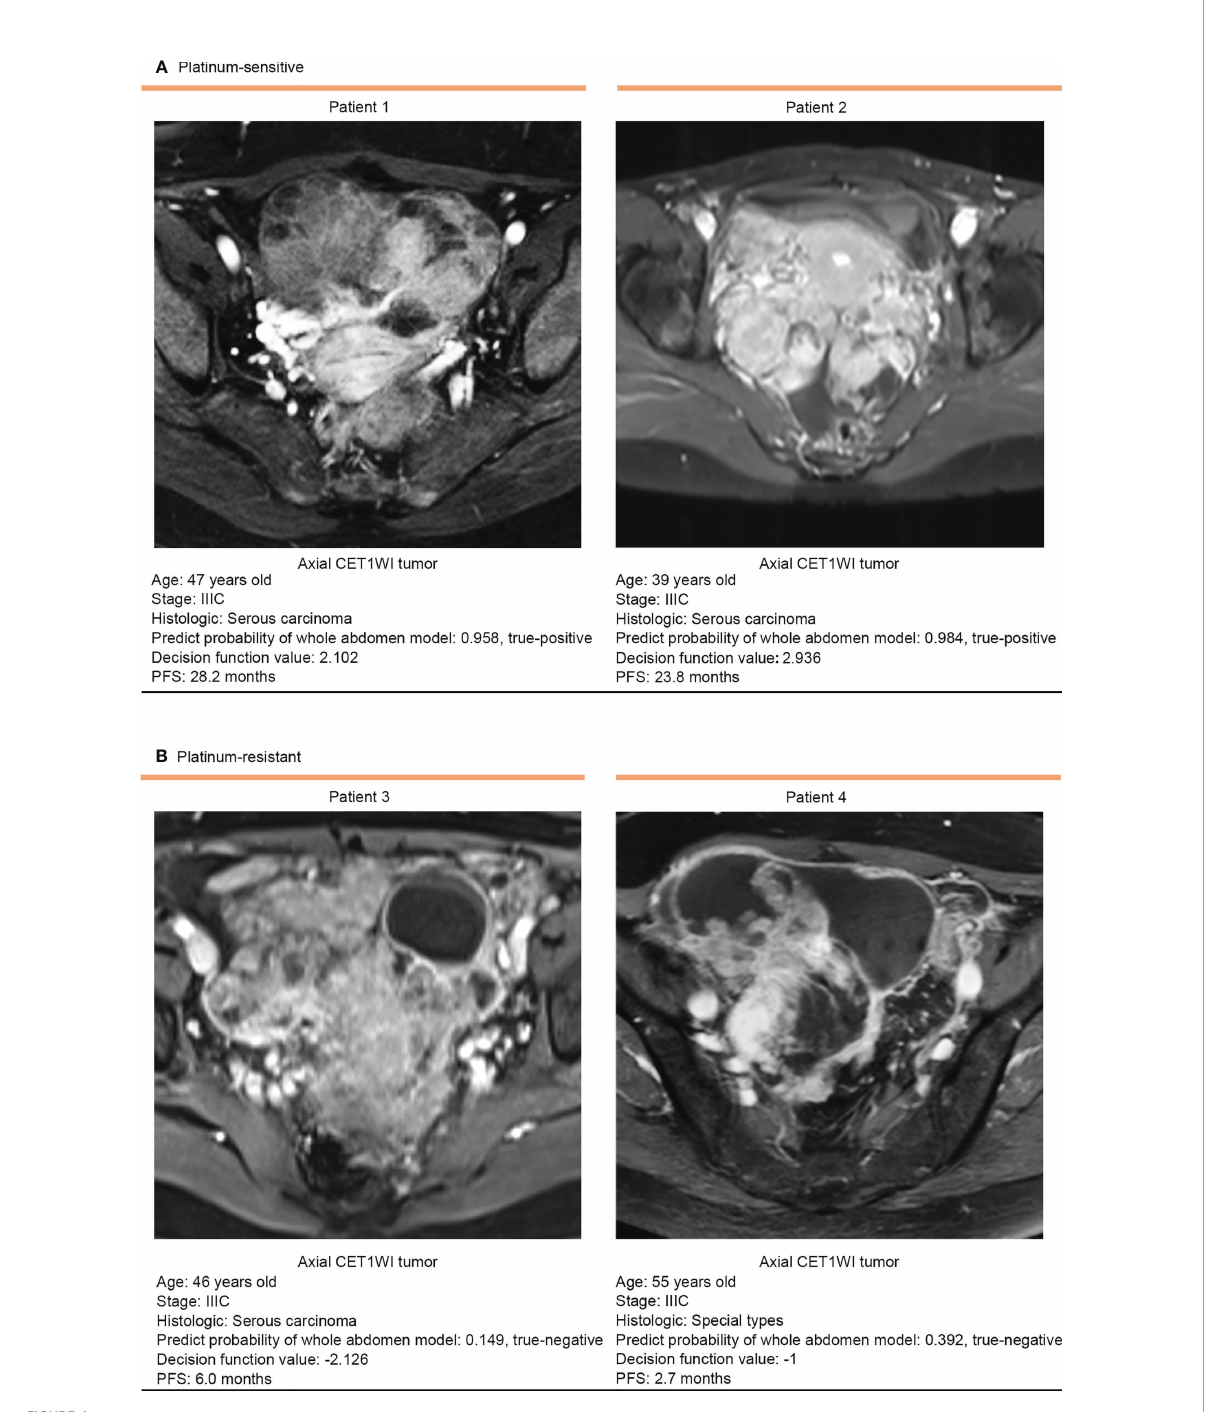
FIGURE 4 Representative prediction results of the whole abdomen model. (A) Patients 1 and 2 were platinum-sensitive and (B) patients 3 and 4 were platinum-resistant. The platinum sensitivity of patients was accurately assessed according to the decision function value by the cutoff value of 0.00. CE-T1WI, contrast-enhanced T1-weighted